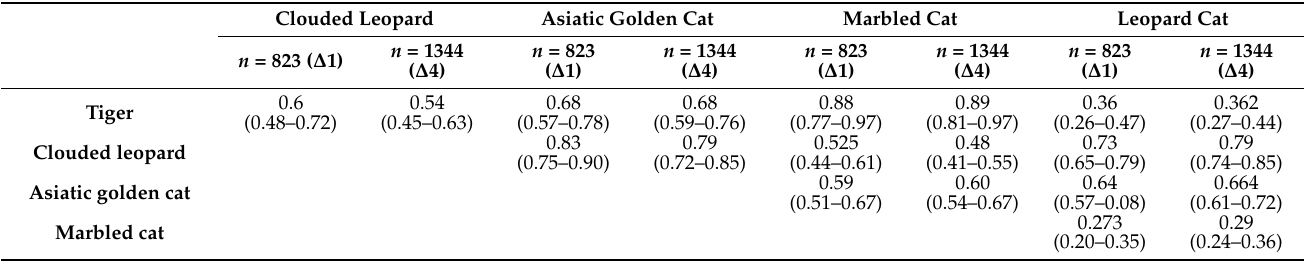
Table 1. Coefficient of overlap in activity pattern of the tiger, clouded leopard, marbled cat, Asiatic golden cat, and leopard cat with 95% confidence intervals for both different sample sizes, n = 823 ( ∆ 1) and n = 1344 ( ∆